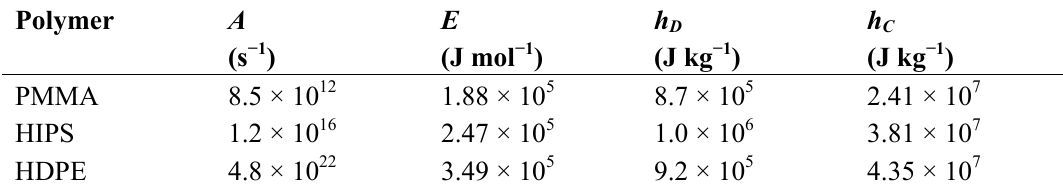
Table 6. Kinetic and thermal properties of selected polymers.